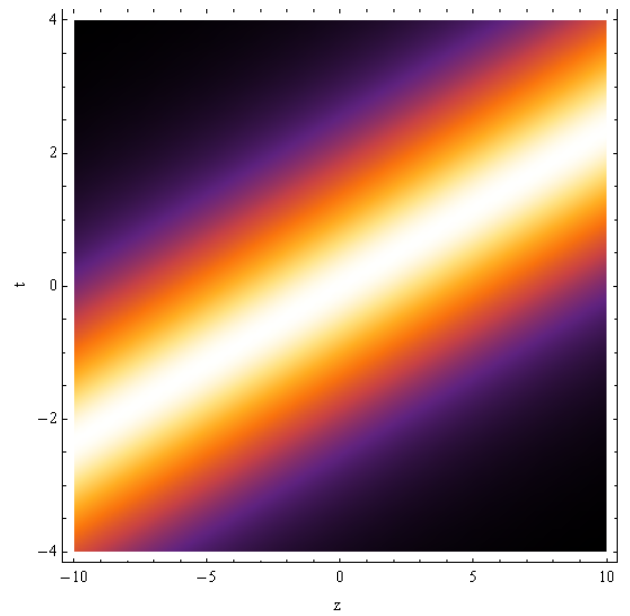
Figure 2. Change of absolute value of solution (18) with z , t for c = 0.5, v = 0.7, β 1 = 0.1, β 2 = 1, β 1 = 0.1, β 3 = 0.3, β 4 = 0.2.